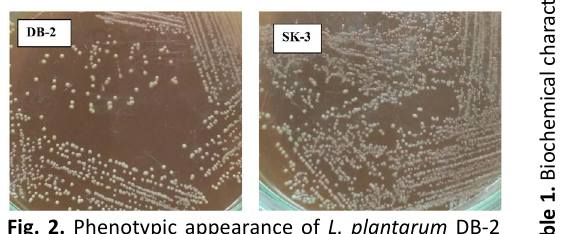
Fig. 2. Phenotypic appearance of L. plantarum DB-2 and